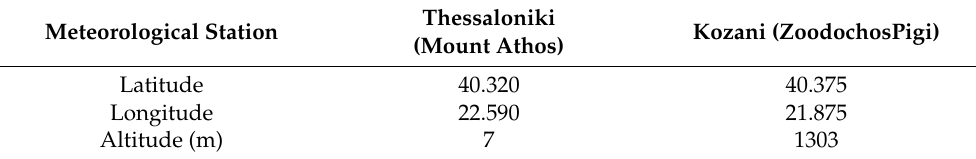
Table 1. Co-ordinates (WGS-84) of the meteorological stations used in the comparison with the satellite data.